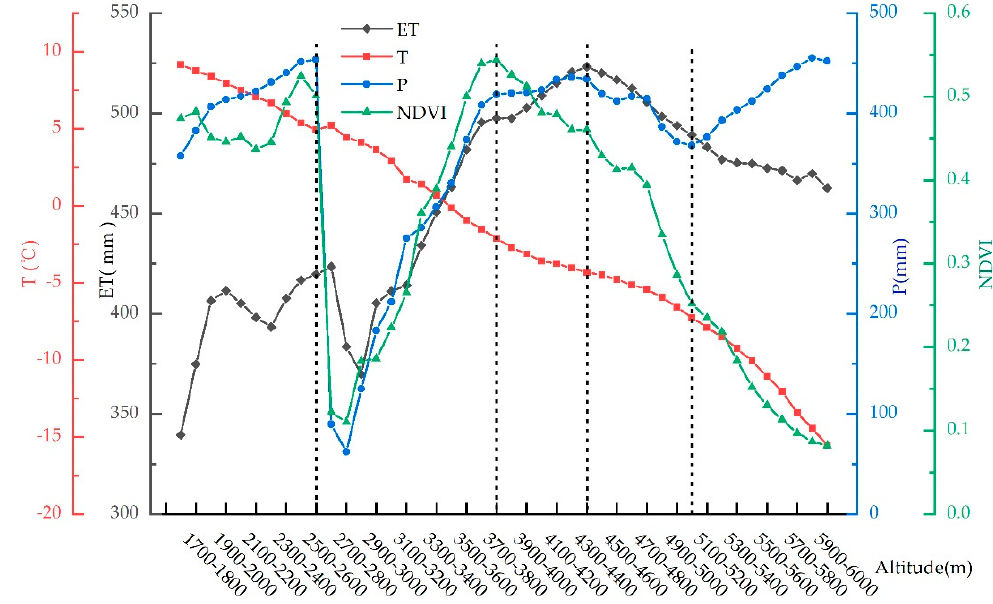
Figure 8. Variations of ET, T, P, and NDVI with